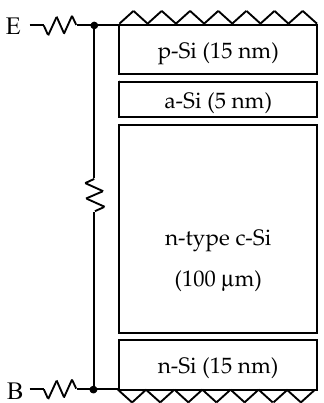
Figure 1. Device structure used for PC1D simulation. Table 2. Minimum set of simulation parameters for heterojunction solar cells.